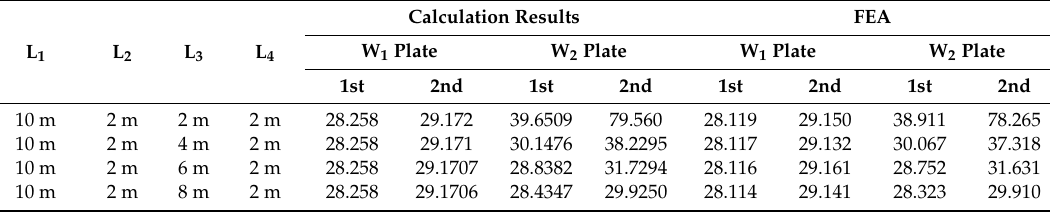
Table 2. The comparison of results (unit: